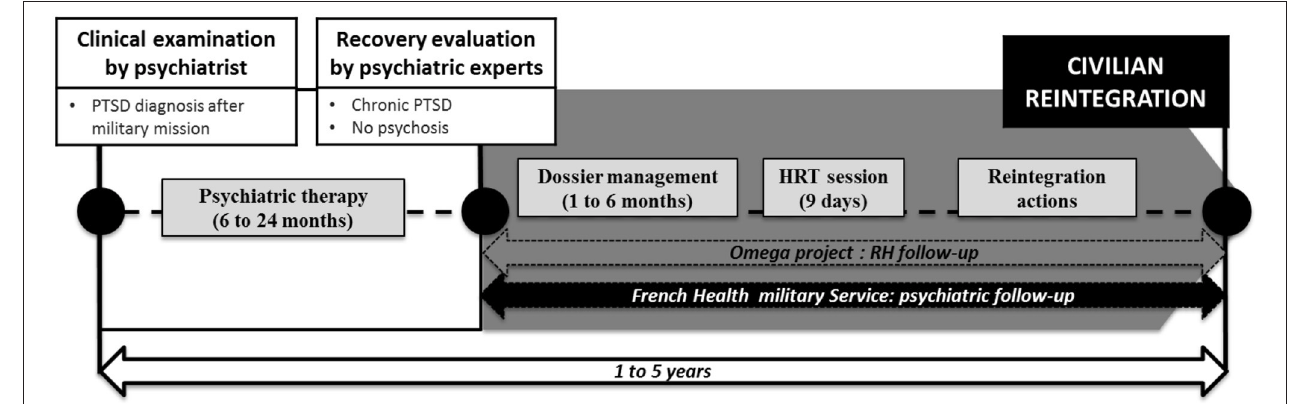
FIGURE 1 | French military rehabilitation for PTSD from diagnosis to reinsertion: position of the omega project. HRT: Human Resources Training.